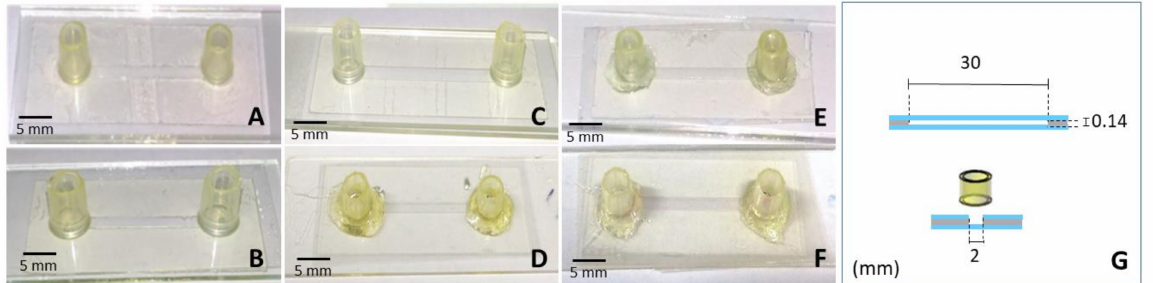
Figure 6. Biocompatible adhesive microchips made of different top-bottom materials: ( A ) glass-glass; ( B ) coverslip-glass; ( C ) glass-Permanox ® ; ( D ) polyester-Permanox ® ; ( E ) glass-polystyrene; ( F ) polyester-polystyrene; ( G ) frontal and lateral section dimensions of biocompatible adhesive microchips illustrating the length (30 mm), the height (0.14 mm) and the width (2 mm) of the